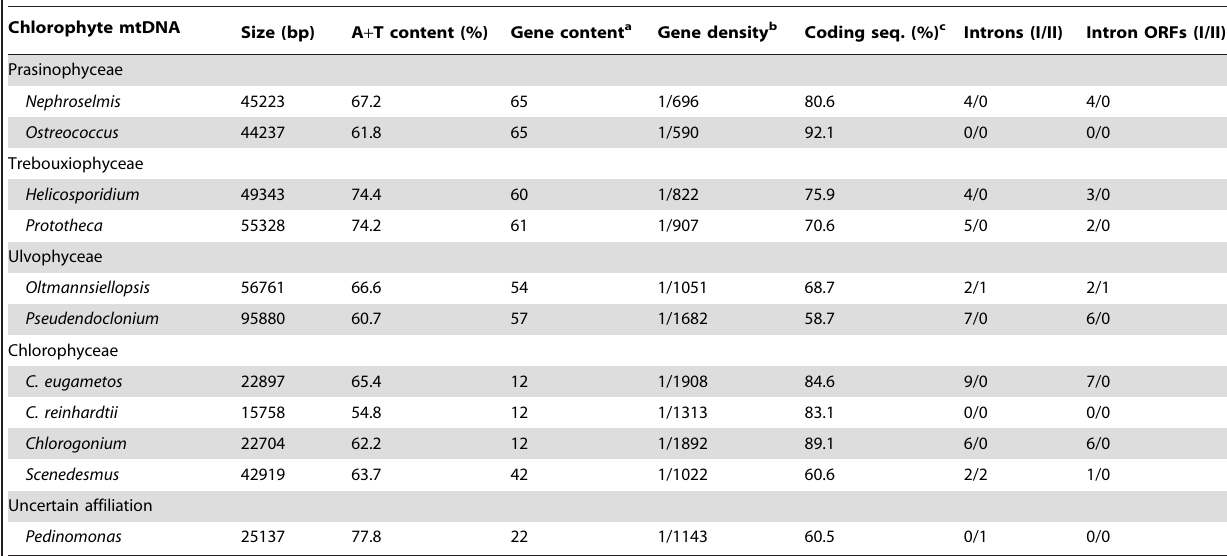
Chlorophyte mtDNA Size (bp) A + T content (%) Gene content a Gene density b